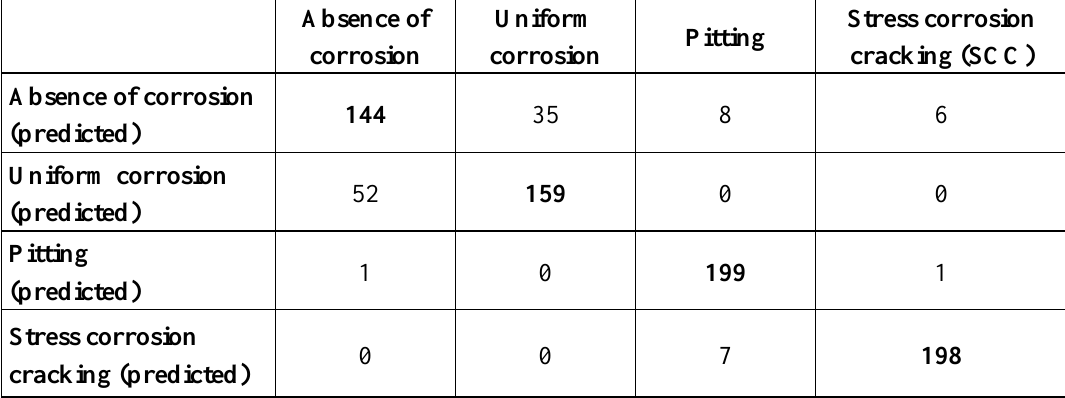
Table 2. Confusion matrix for the naïve Bayes classifier using 27 wavelet coefficients. The numbers are obtained using all 10 test folds from the 10 fold